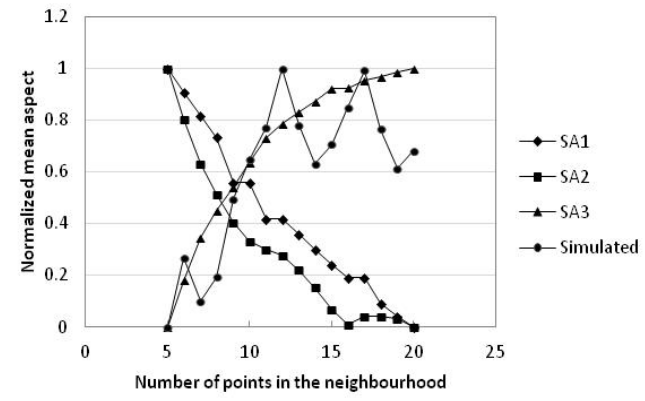
Figure 7. Plot of mean aspect with number of points in the neighbourhood in study areas 1–3 and simulated